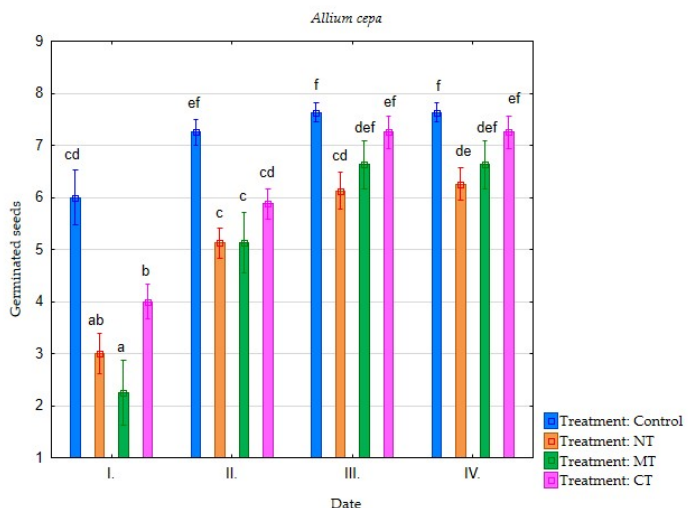
Figure 5. Development of the germination of Allium cepa caryopses watered with soil leachates from different soil tillage. The results represent the mean of 8 biological replicates ± SE. Identical letters express statistical non-significance between the variants, different letters express statistical significance at a significance level p = 0.05 (Fisher LSD test). The plot shows the mean, the whiskers representing the standard error, values with different letter (a, b, c, d, e, f) differ significantly. Variants of tillage technologies: CT—Conventional tillage with ploughing; MT—Minimum tillagethe; NT— Direct sowing.